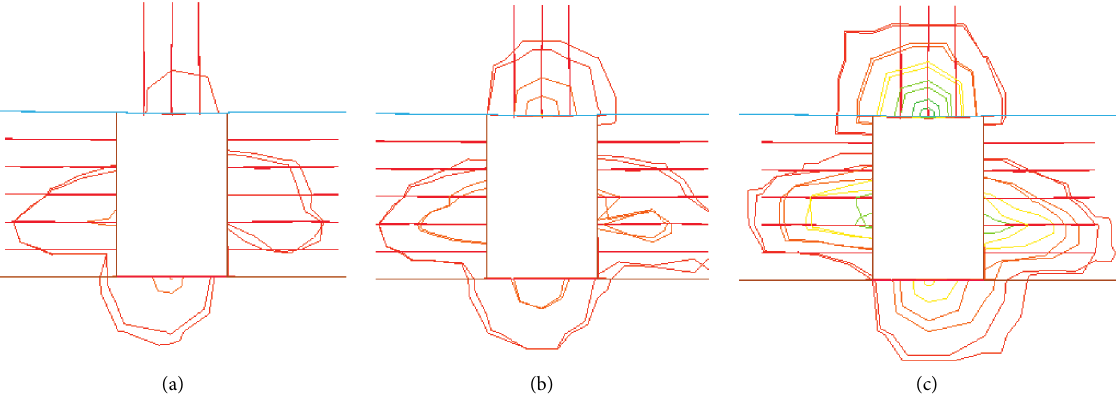
Figure 10: Transmission process diagram of reflected stress wave around roadway: (a) 1s; (b) 1.5 s; (c) 2s.